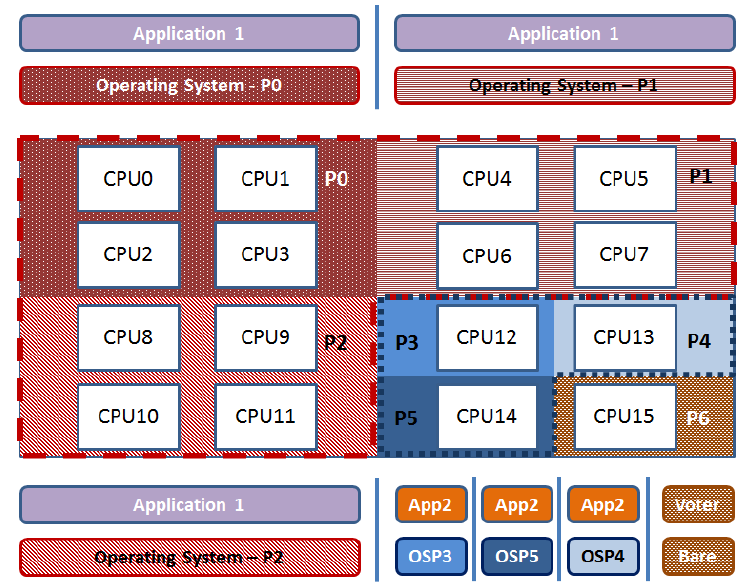
Figure 1. The N-Modular Redundancy and M-Partitions